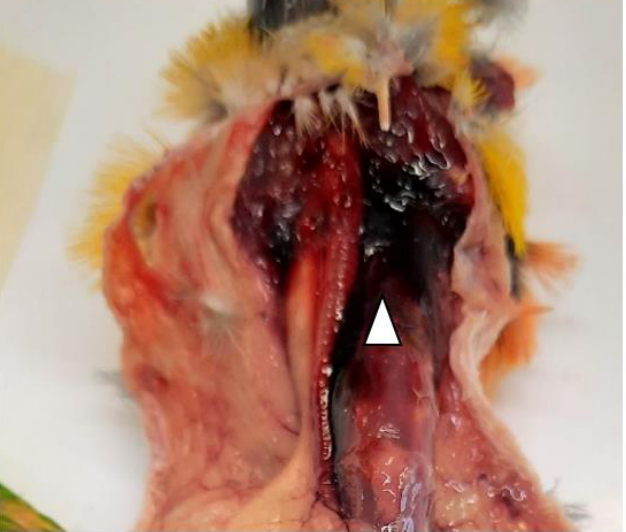
Figure 1. Hyperemic and congestive neck region (white arrowhead) identified during the necropsy of the Caique.